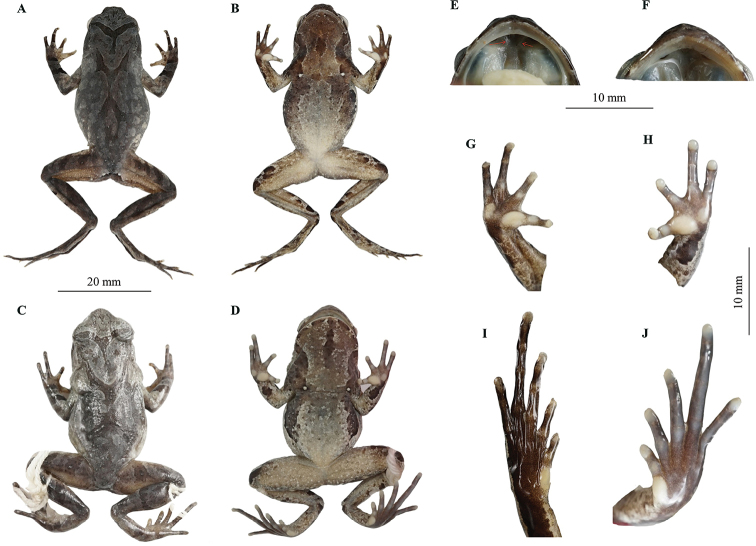
Holotype CIBXJ190503 of Megophrys
xianjuensis sp. nov. and holotype CIBWYF00164 of M.
lishuiensisA, B dorsal view and ventral of Megophrys
xianjuensis sp. nov., respectively C, D dorsal view and ventral of M.
lishuiensis, respectively E oral of Megophrys
xianjuensis sp. nov. showing vomerine ridges (red arrows) F oral of M.
lishuiensis showing no vomerine ridge G ventral view of hand of Megophrys
xianjuensis sp. nov. H ventral view of hand of M.
lishuiensisI ventral view of foot of Megophrys
xianjuensis sp. nov. J ventral view of foot of M.
lishuiensis.